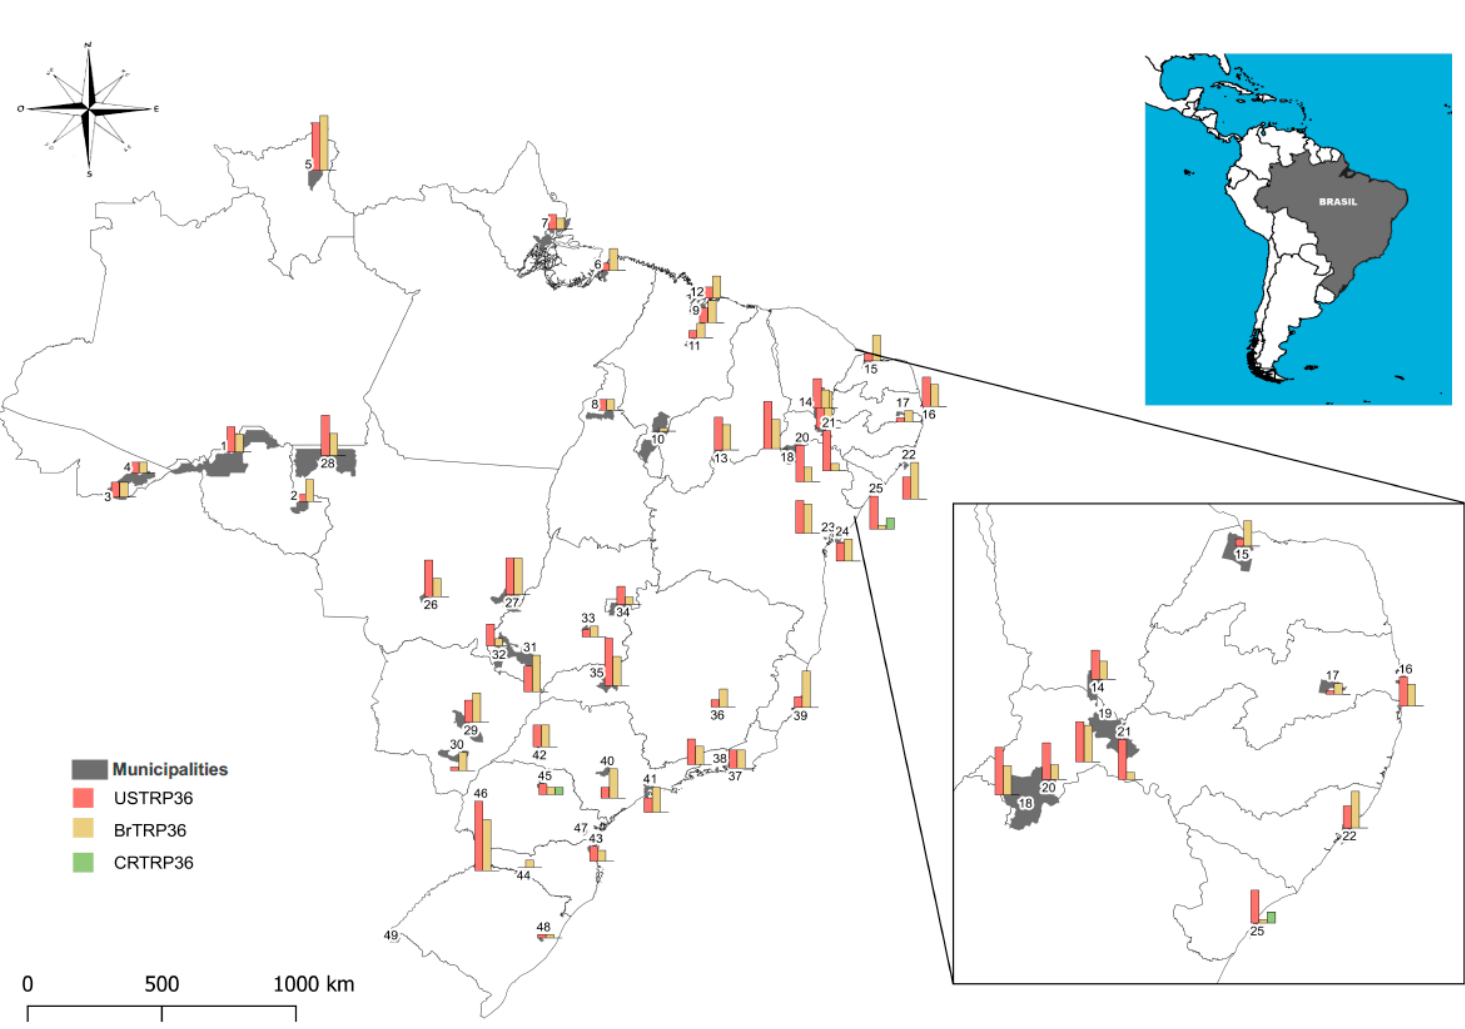
Figure 1. Distribution of E. canis genotypes in Brazil.